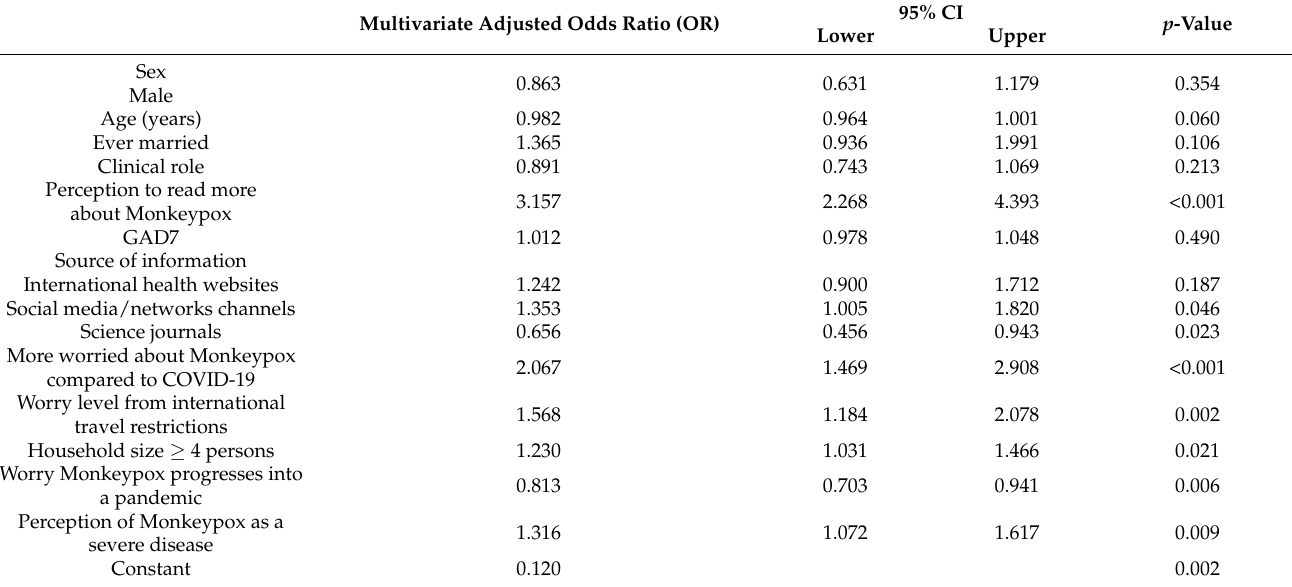
Table 6. Multivariate binary logistic regression analysis of the HCW’s odds of supporting the Implementation of tighter infection control measures against Monkeypox compared to those cur- rently applied. Multivariate Adjusted Odds Ratio